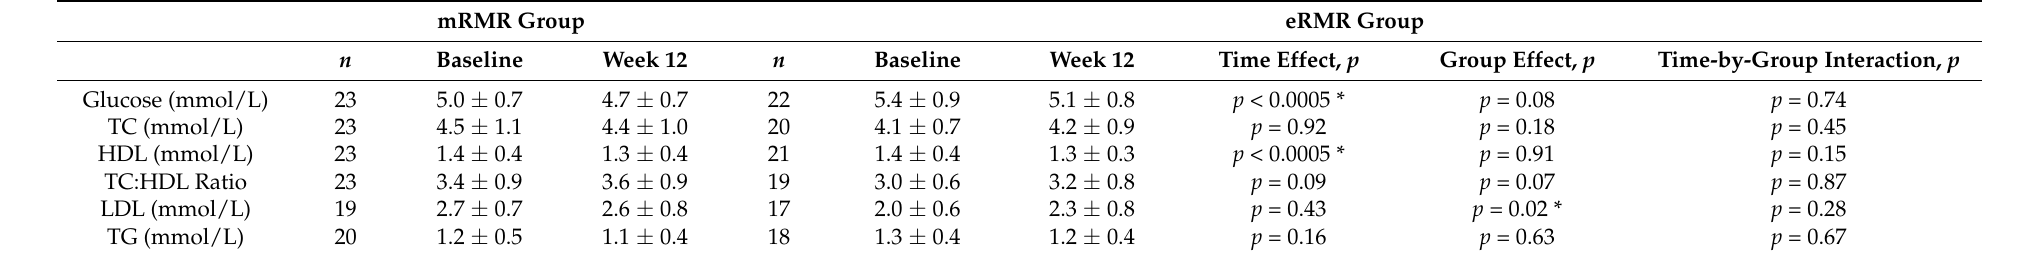
Table 4. Biochemical outcomes at baseline and week